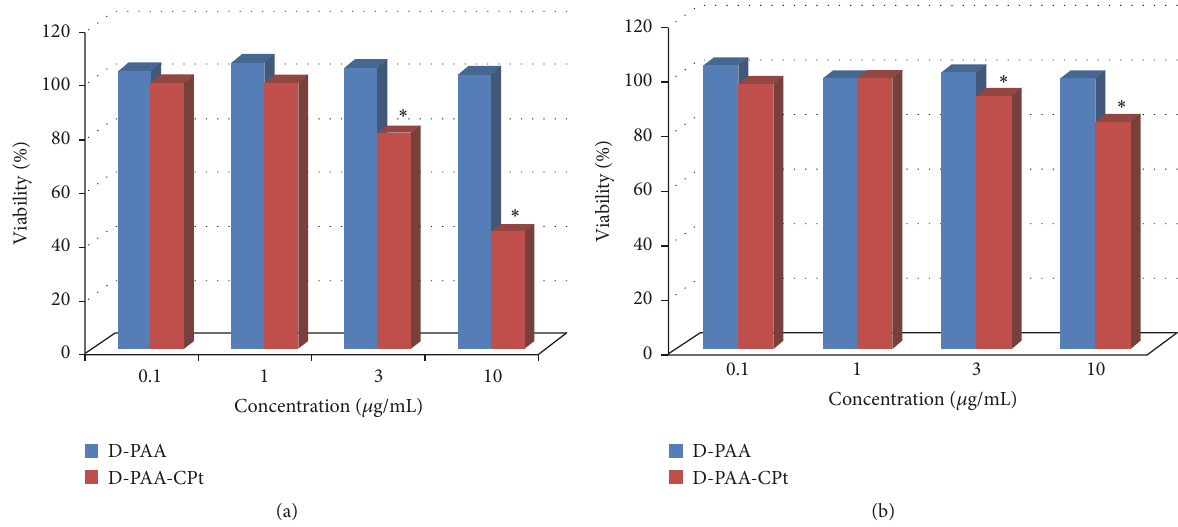
Figure 4: Viability (%) of U-937 (a) and K-562 (b) cells after treatment with the nanoparticles (D-g-PAA(PE) and D-g-PAA(PE)/cisplatin) assessed by MTT test. Data are means ± SD; ∗ significant difference between two groups ( 𝑃 < 0.05 ).